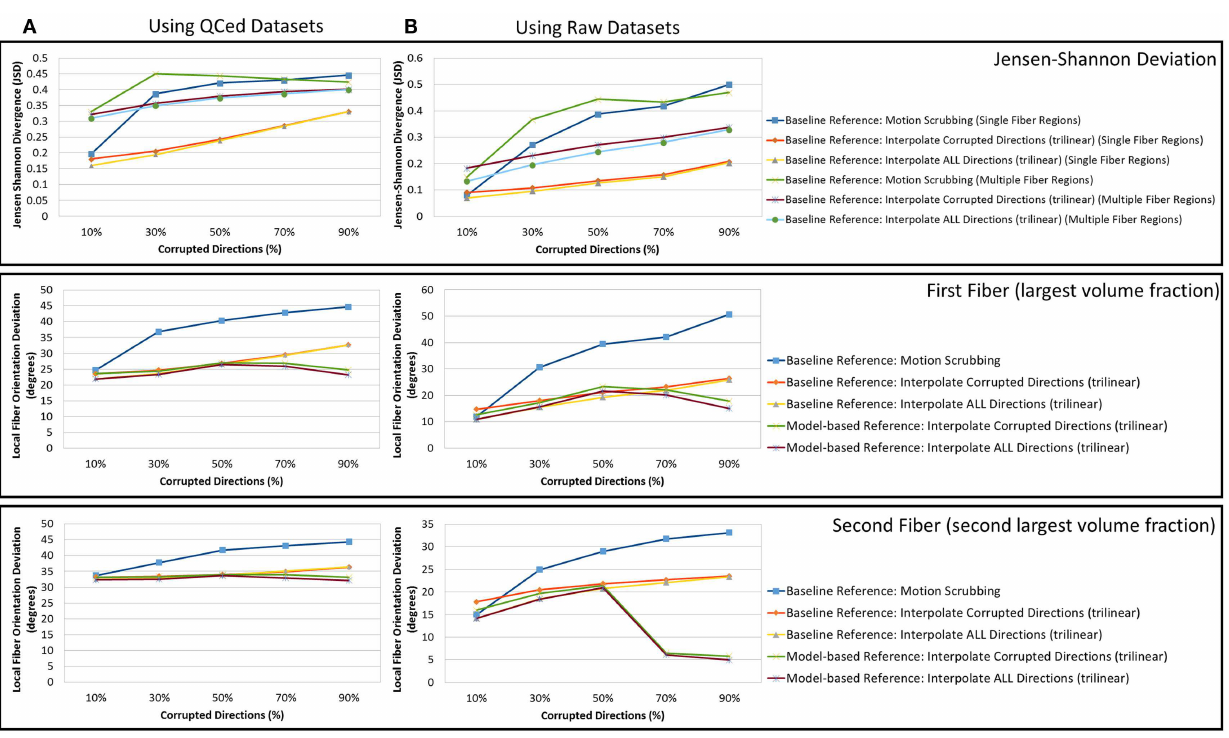
FIGURE 13 |The average Jensen–Shannon divergence (JSD) values (first row) and the average fiber orientation deviation (second and third row), a function of motion corrupted percentage for reconstructions based on gold standards generated from (A) the QCed phantom dataset and (B)